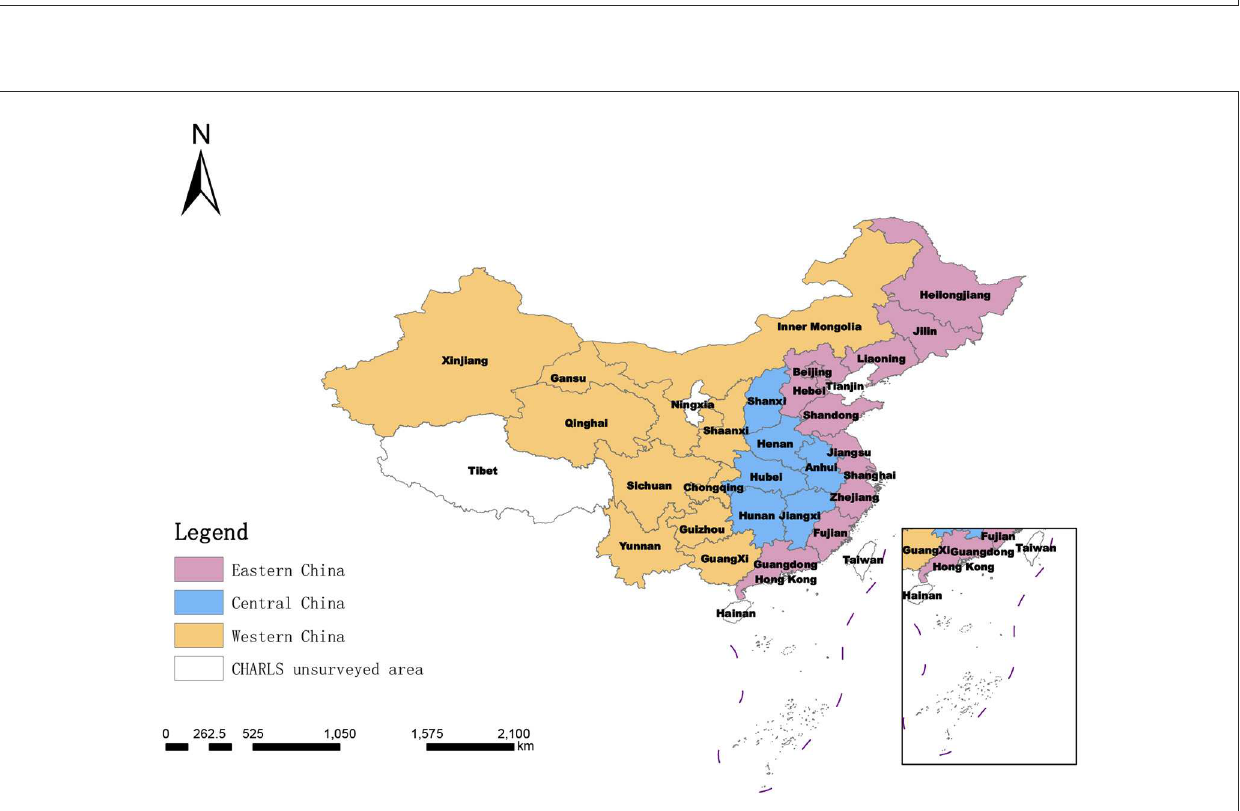
FIGURE3 The eastern, central, and western regions of